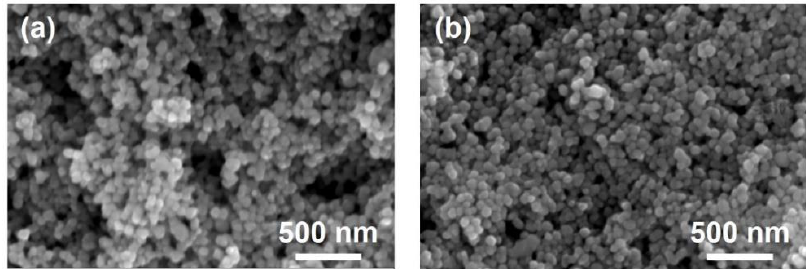
Figure 4. Microstructures of the interconnects sintered with ( a ) the one-step and ( b ) the two-step processes,